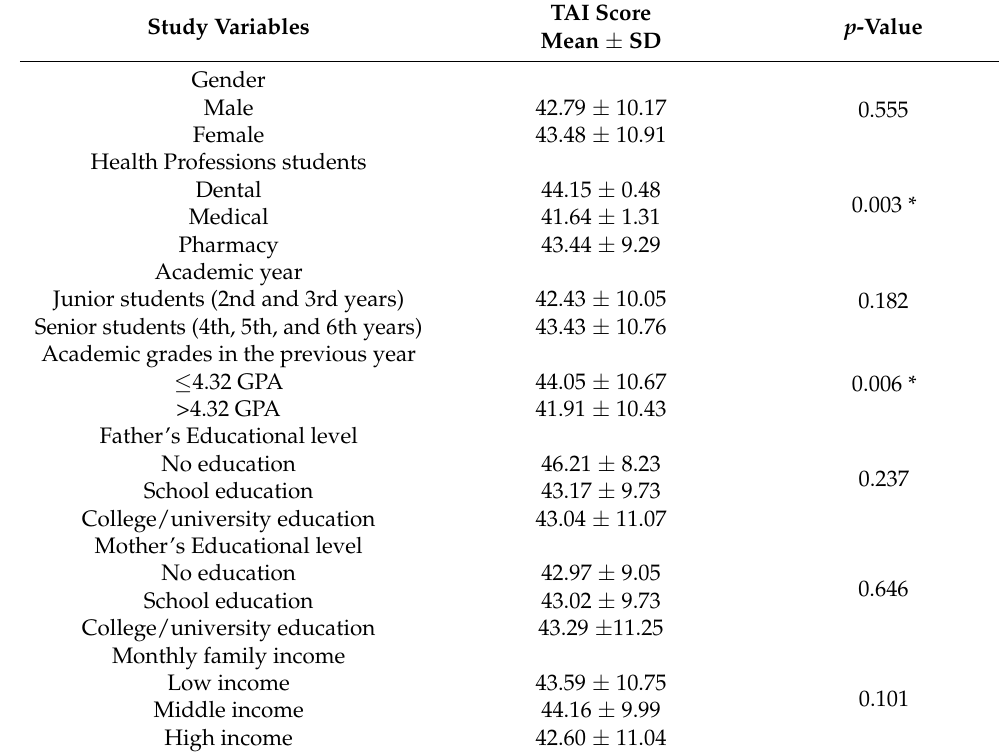
Table 2. Bi-variate analysis: Relationship between test anxiety and demographic factors among students. Study Variables